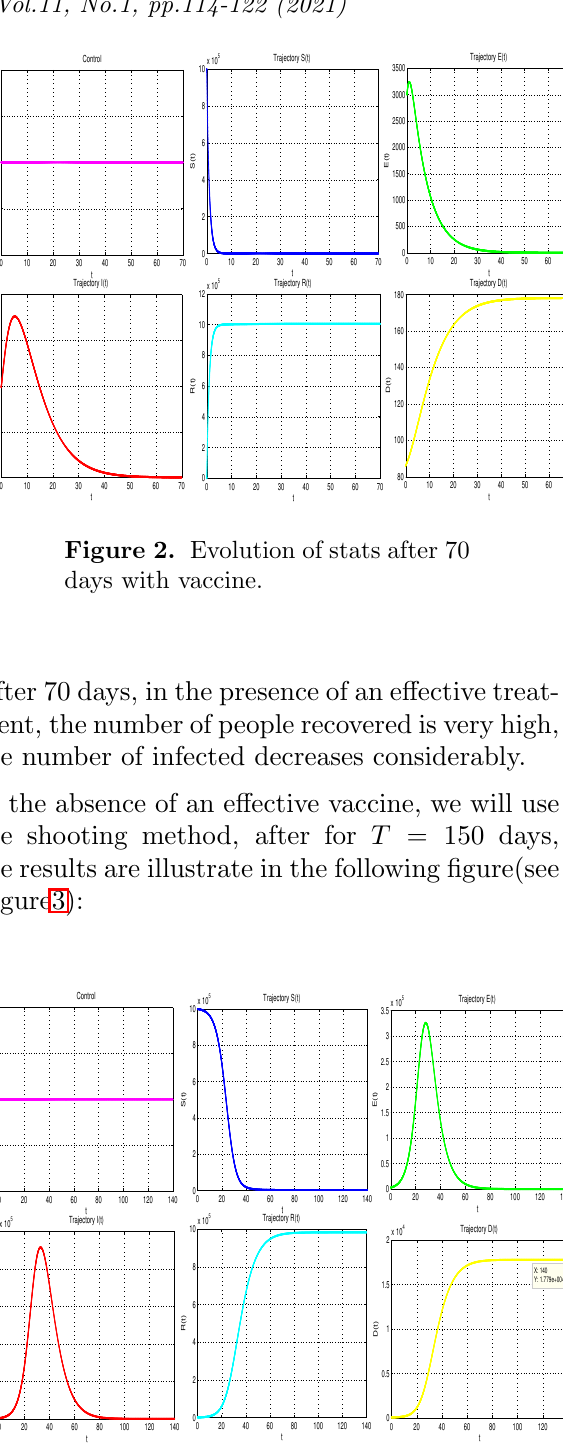
Figure 3. Evolution of stats after 150 days without vaccine.